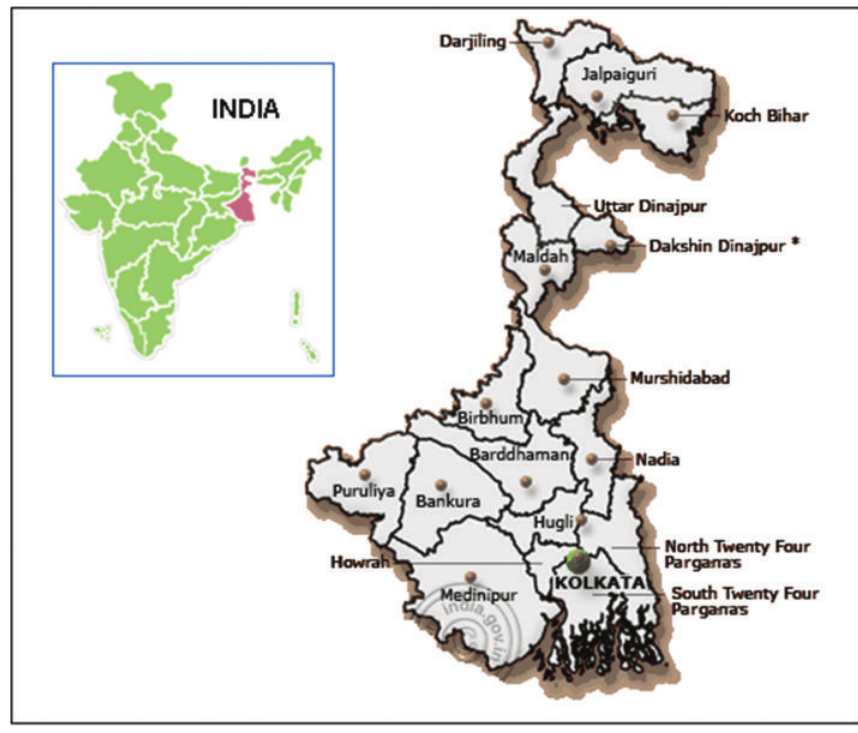
Figure 1: The geographical location of Kolkata in West Bengal (region of study).